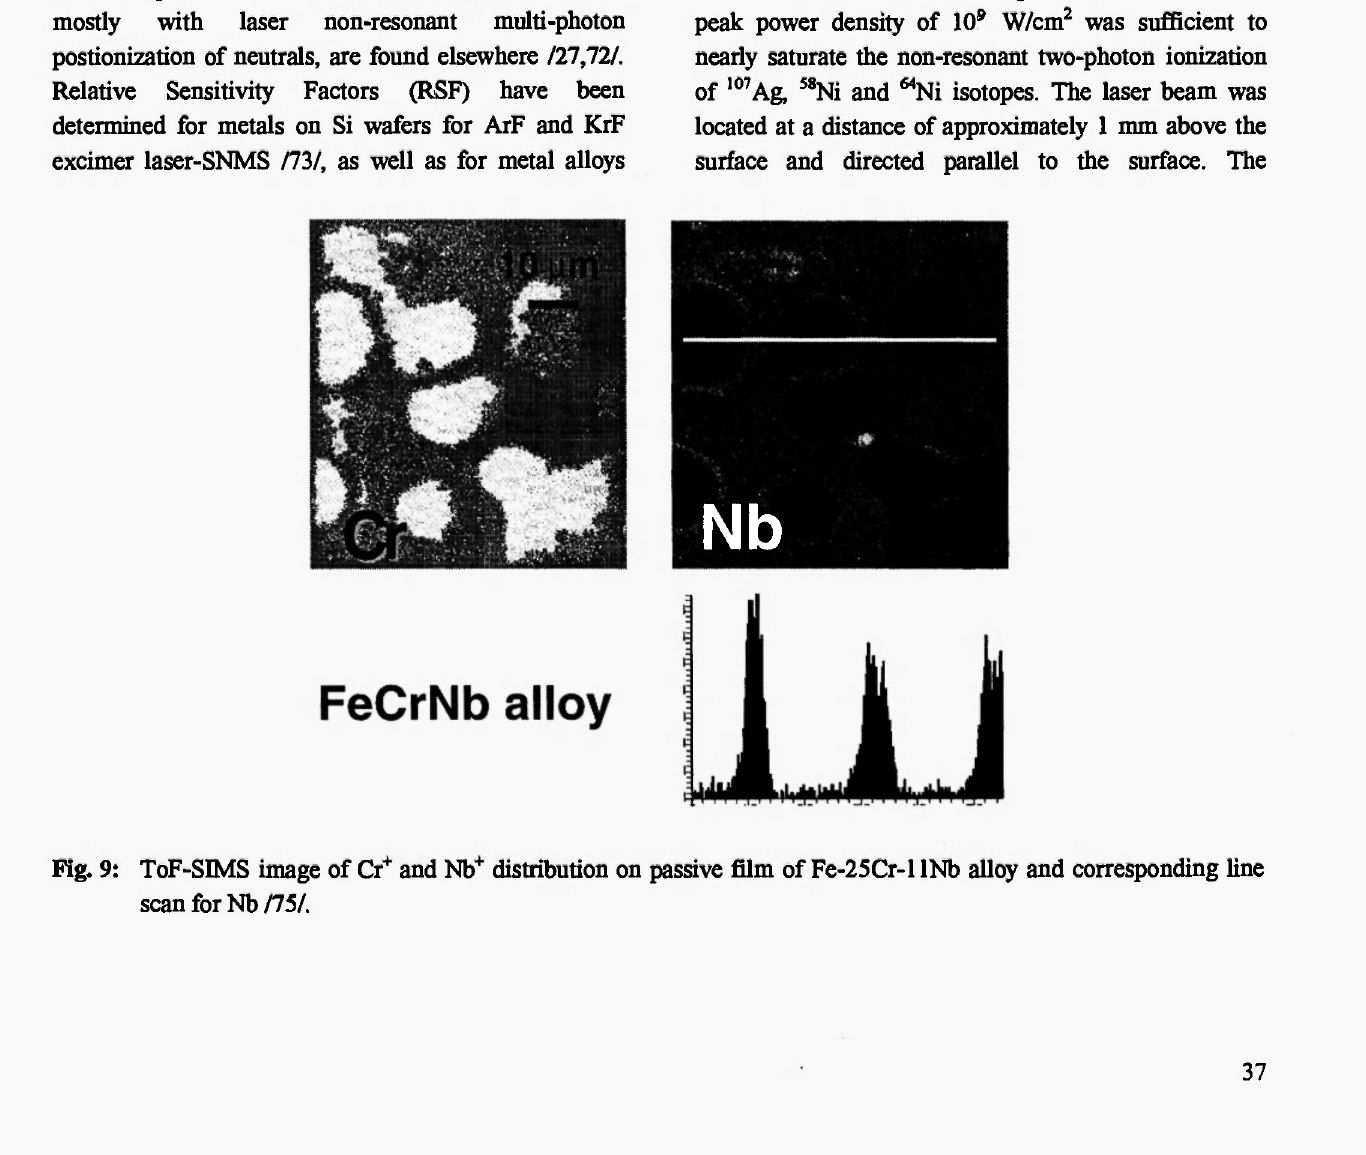
Fig. 9: ToF-SIMS image of Cr + and Nb + distribution on passive film of Fe-25Cr-llNb alloy and corresponding line scan for Nb